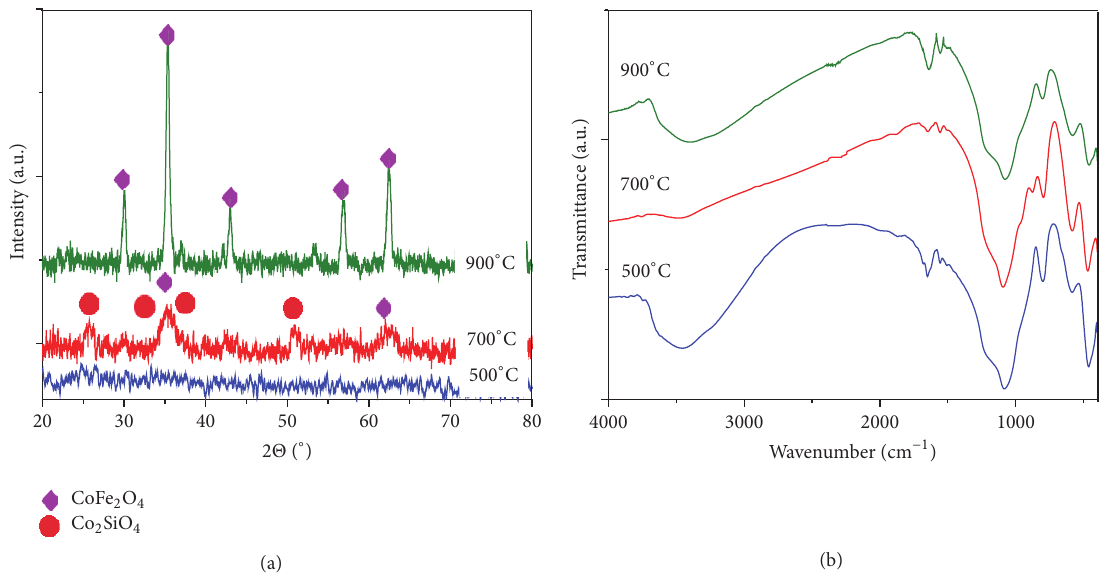
Figure 2: XRD patterns (a) and FT-IR spectra (b) of the gels obtained using 1,2-ED, annealed at 500, 700, and 900 ∘